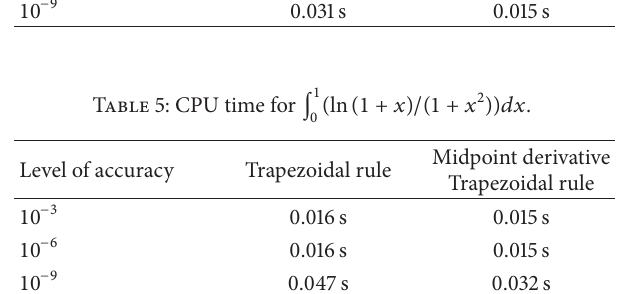
Table 4: CPU time for ∫